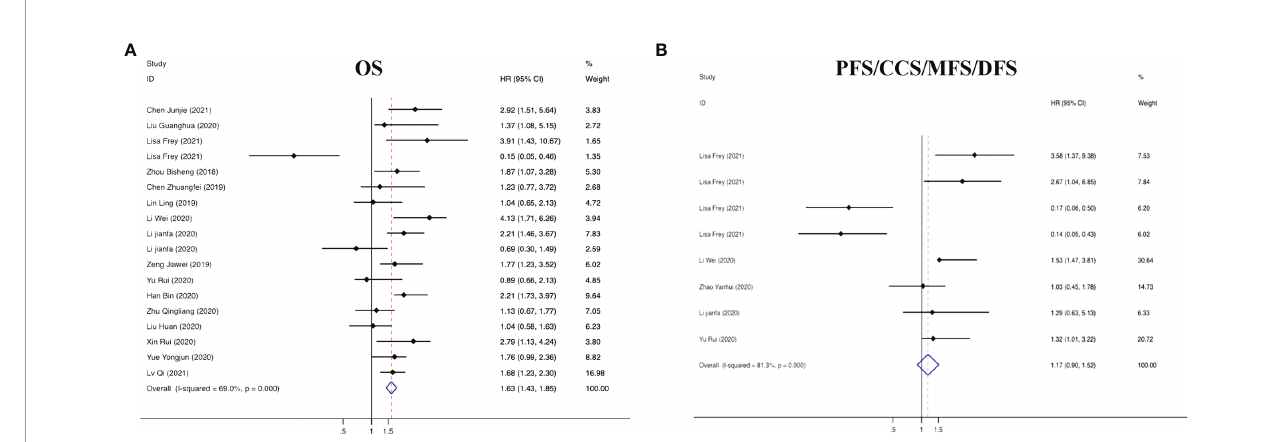
FIGURE 4 | Forest plots of the (A) OS and (B) PFS/CCS/MFS/DFS of RC patients for circRNAs.